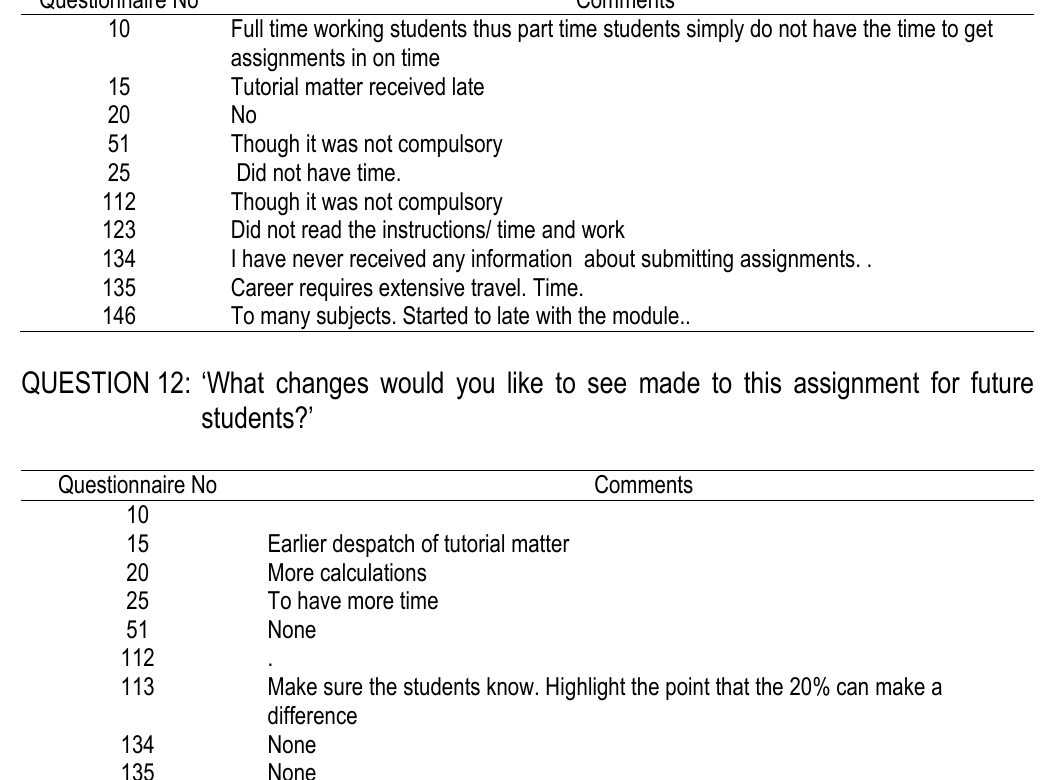
Put a red sticker on first page of study guide tut letter to warn about the pending assignment. would like extension of time to be given if problem